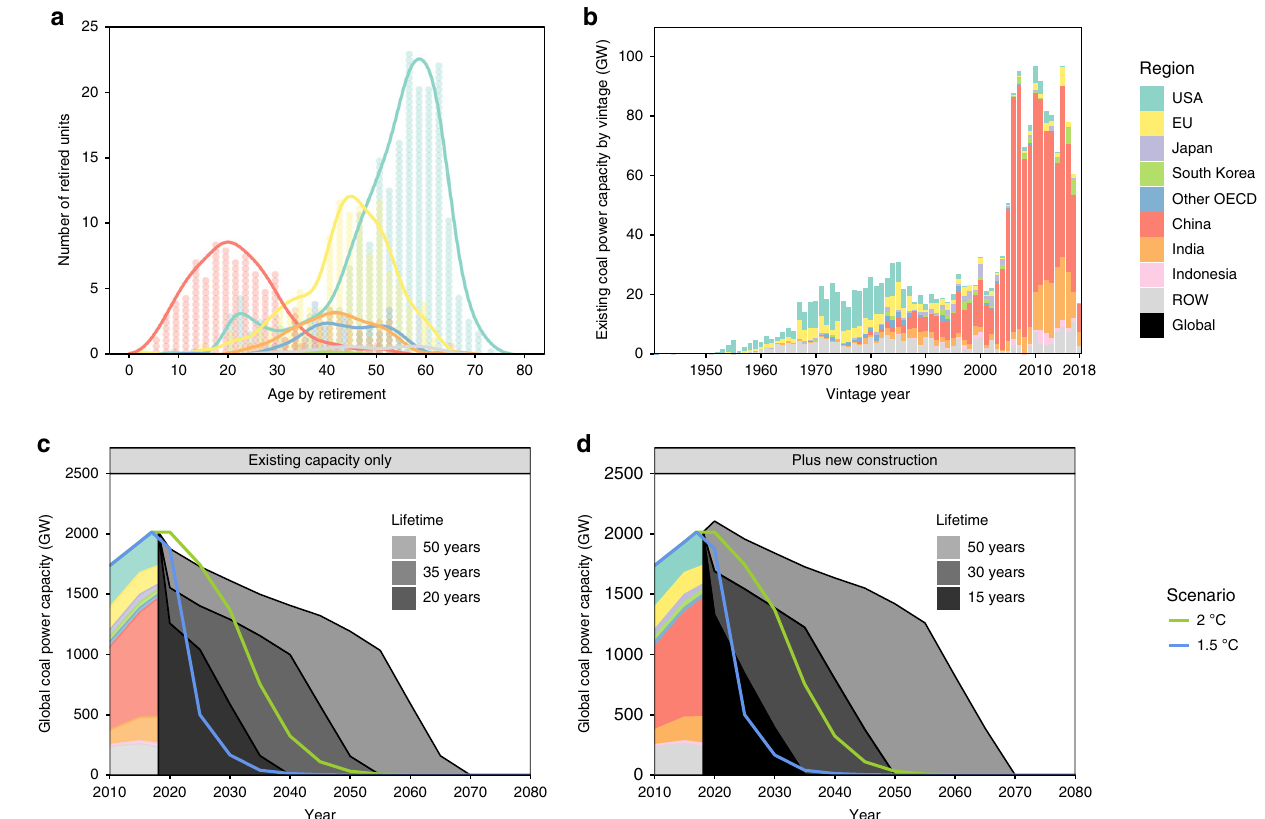
Fig. 3 Lifetime limits for coal power plants. We show lifetimes of retired units ( a ) and the vintage year of existing units ( b ) and calculate global coal capacity under different plant lifetimes, compared to capacity levels consistent with a well-below 2 °C (green) and 1.5 °C (blue) pathway, for a case where no new coal plants are built ( c ) and where plants currently under construction come online as scheduled, but those in planning or permitting stages are not built ( d ). Capacity pathways for the well-below 2 °C and 1.5 °C scenarios use a least cost global mitigation scenario starting 2025. Allowing plants currently under construction to come online shortens the retirement timeline by 5 years (i.e., 35- versus 30-year lifetimes for the 2 °C scenario and 20- versus 15-year lifetimes for the 1.5 °C